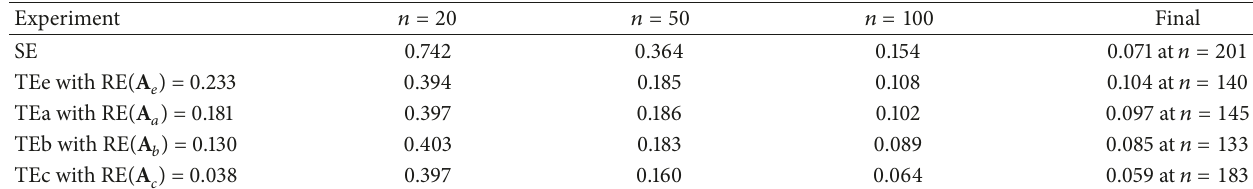
Table 5: As in Table 4 but for the two-dimensional case in Figure 11 where the second set of innovations is used with periodic extension. Experiment 𝑛 = 20 𝑛 = 50 𝑛 = 100 Final SE 0.757 0.364 0.175 0.069 at 𝑛 = 241 TEe with RE( A 𝑒 ) = 0.462 0.416 0.202 0.149 0.144 at 𝑛 = 140 TEa with RE( A 𝑎 ) = 0.274 0.411 0.202 0.143 0.144 at 𝑛 = 215 TEb with RE( A 𝑏 ) = 0.244 0.402 0.195 0.136 0.132 at 𝑛 = 191 TEc with RE( A 𝑐 ) = 0.165 0.403 0.179 0.106 0.103 at 𝑛 =